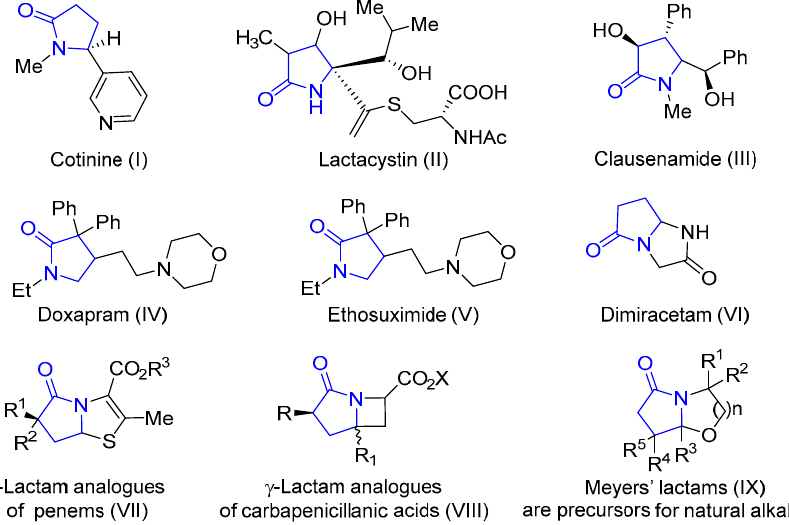
Figure 1. Examples of bioactive γ -lactams.